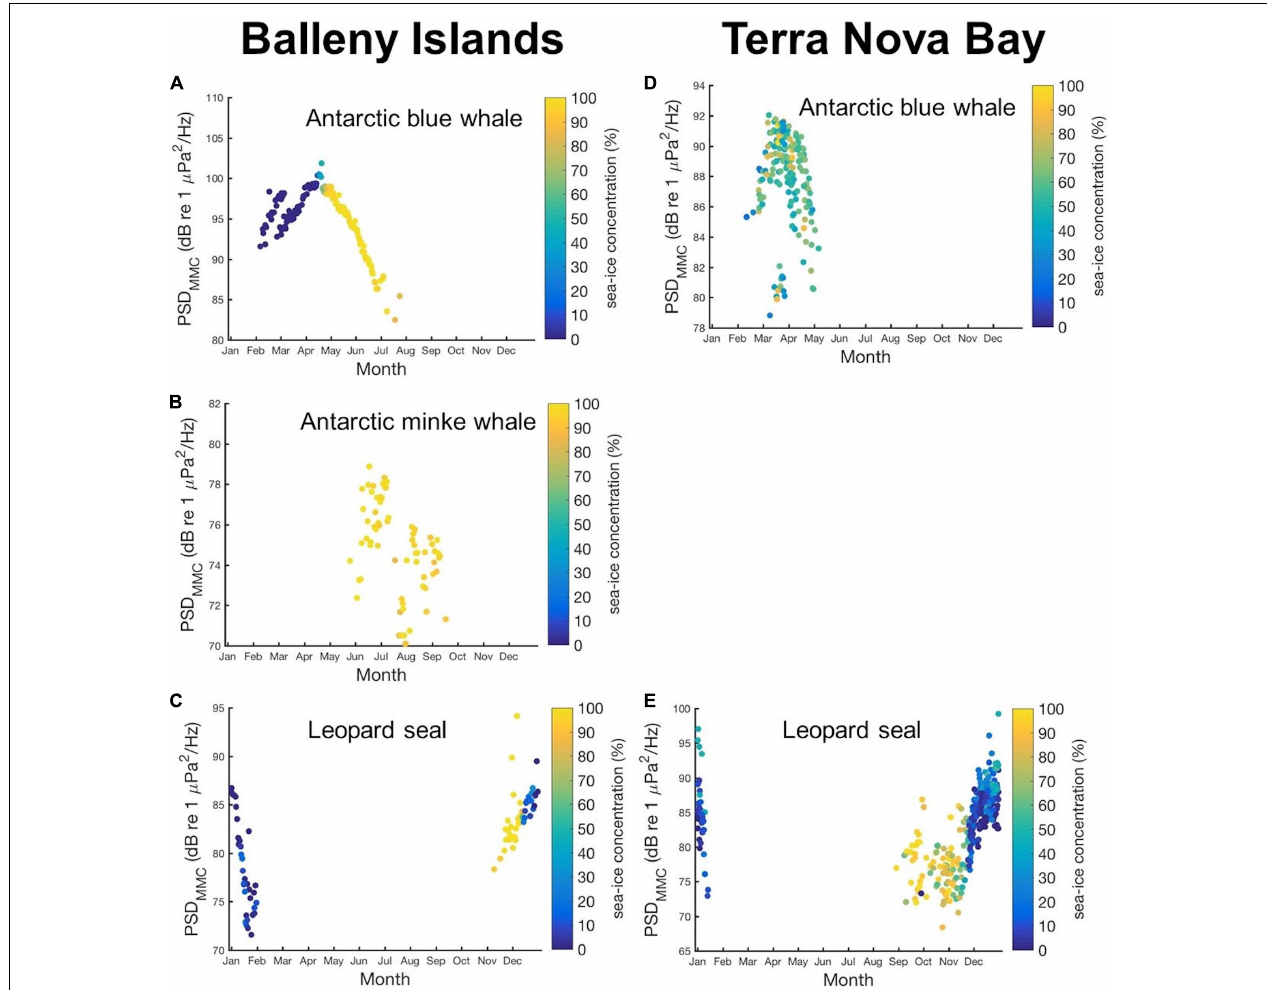
FIGURE 8 | Scatter plots of annual PSD MMC values with different sea-ice concentrations represented in color for (A) Antarctic blue whales, (B) Antarctic minke whales, and (C) leopard seals in the BI region, and for (D) Antarctic blue whales and (E) leopard seals in TNBP.